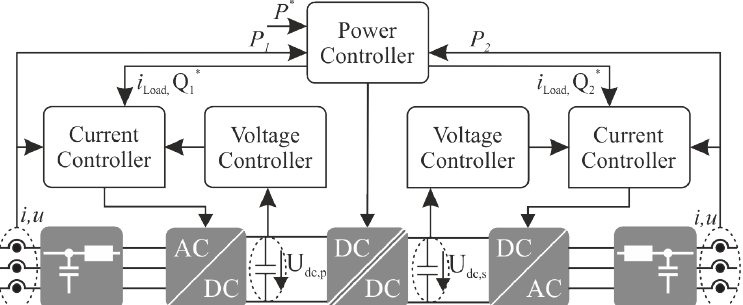
Figure 3. Three-stage SST control